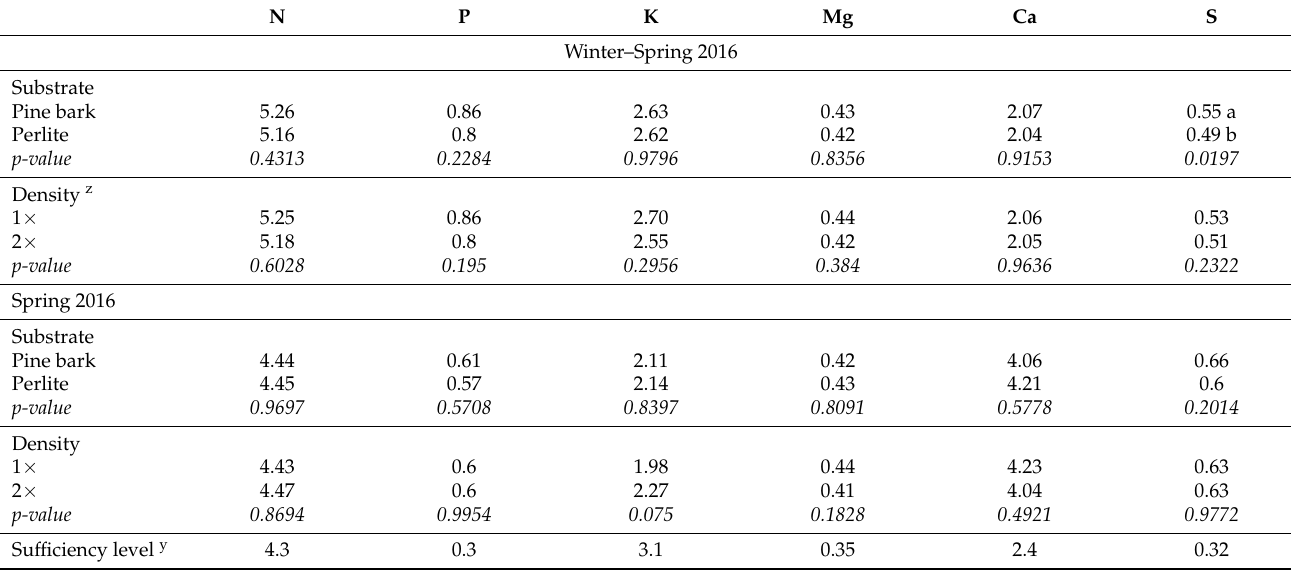
Table 3. Effect of substrate and planting density on foliar macronutrient concentration (g 100 g − 1 dry mass) of ‘Socrates’ cucumber in two trials in